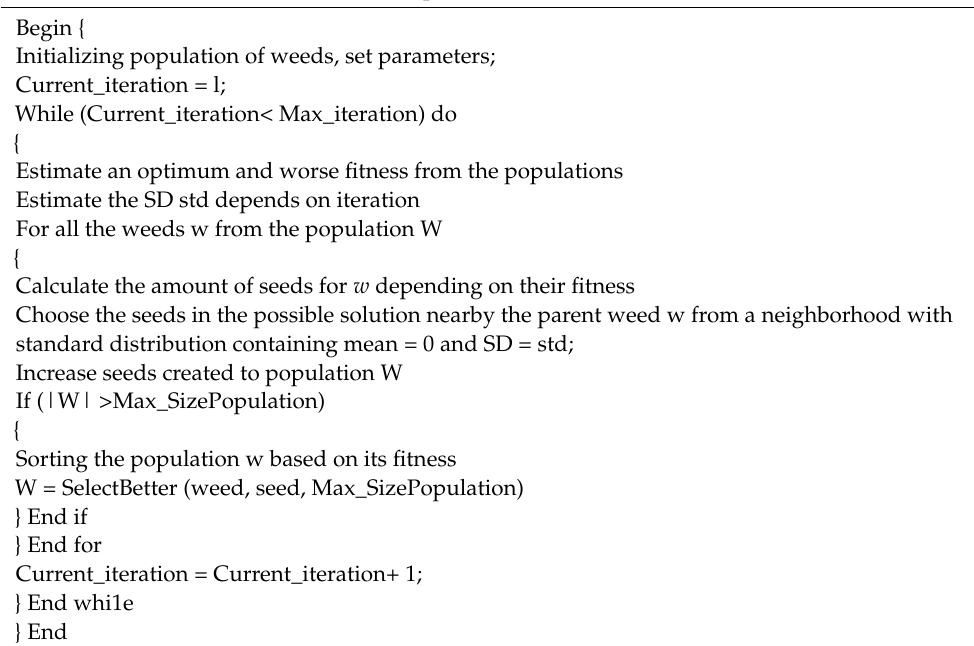
Algorithm 2: Pseudocode of IWO technique